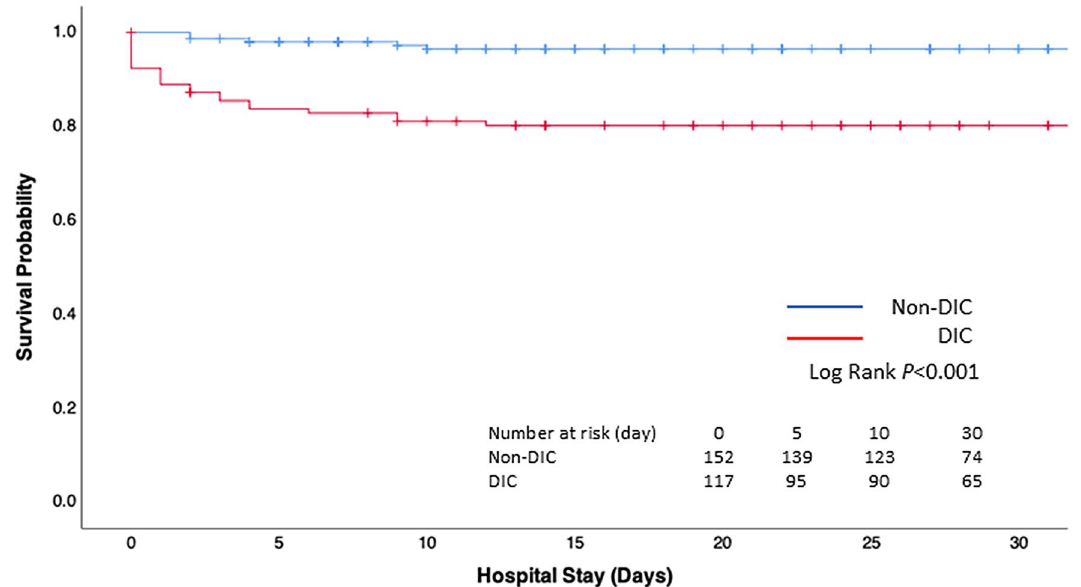
Figure 1. Kaplan–Meier survival probability curves for mortality during hospitalization. Numbers at risk represent the number of patients with or without disseminated intravascular coagulation (DIC) at risk of death at the indicated